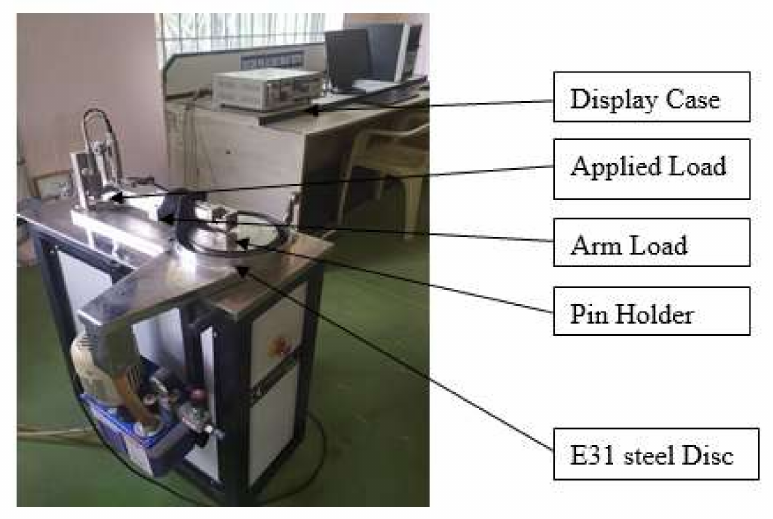
Figure 2. DUCOM Pin on Disc